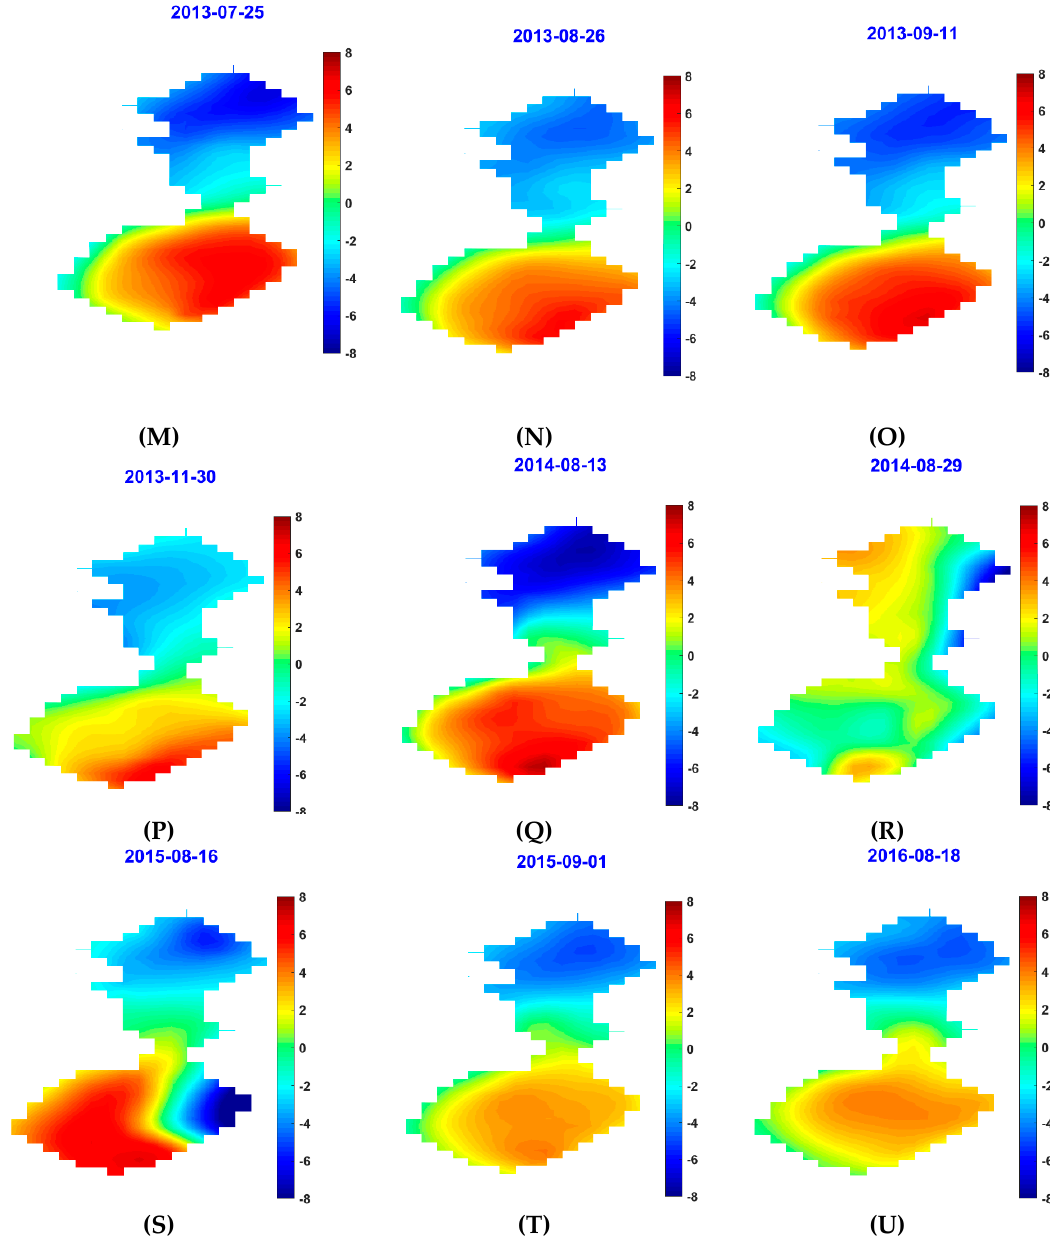
Figure 6. Thermal map of Bridgeton landfill displaying LST in degree Celsius (°C) at various times and dates from 2000–2011: September 7, 2000 ( A ); October 9, 2000 ( B ); July 8, 2001 ( C ); July 14, 2003